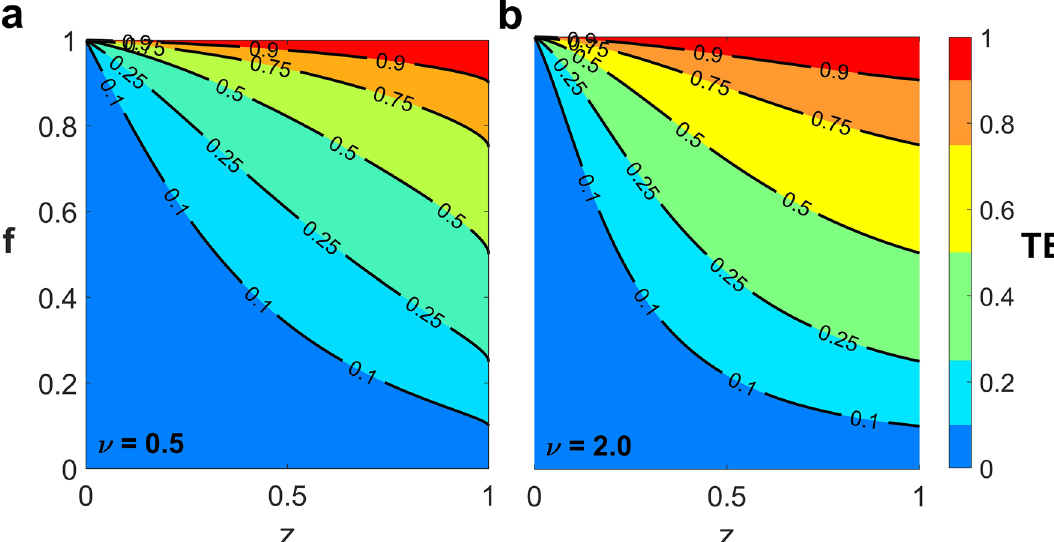
Figure 3. Contours of treatment efficacy. The treatment efficacy ( TE ) is plotted in (z, f) space with ν = 0.5 ( a ) and 2.0 ( b ) with e m = 0.8 (see Table 1 for parameter values). Each section represents different TE with different